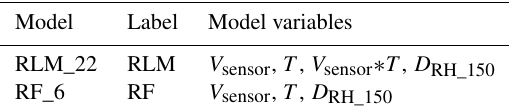
Table 3. Model variables considered in the selected RLM and RF calibration models. The two models were denoted in the study as the “RLM” and “RF”